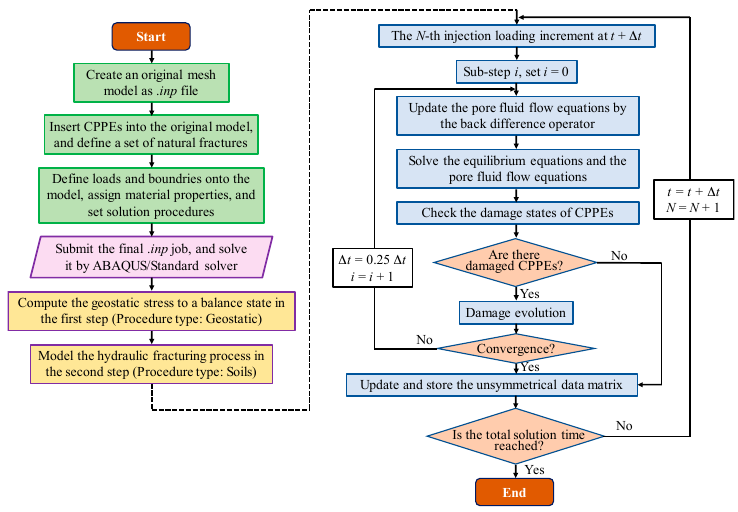
Figure 8. The preprocessing and the solving procedures of the ABAQUS/Standard solver. The module ‘soils’ was used to model hydraulic fracturing. The direct backward difference operator was used to optimize the accuracy of the continuity equation.